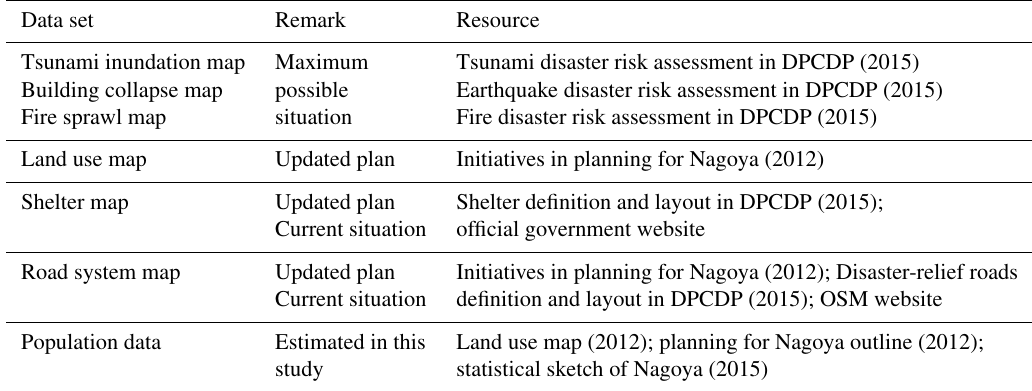
Table 1. List of data sets used for this